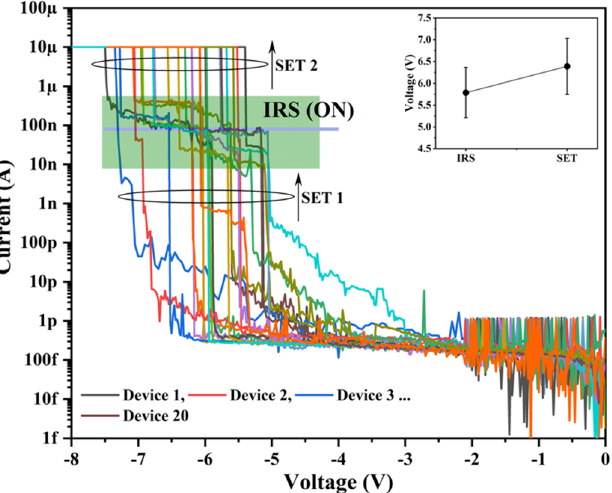
Figure 2. Device-to-device variation of I-V curves in the electroforming process. Inset shows the voltage at which the two-step forming process occurs, IRS (SET 1) and SET 2. Different color lines indicate the I-V curves (electroforming) of 20 devices.